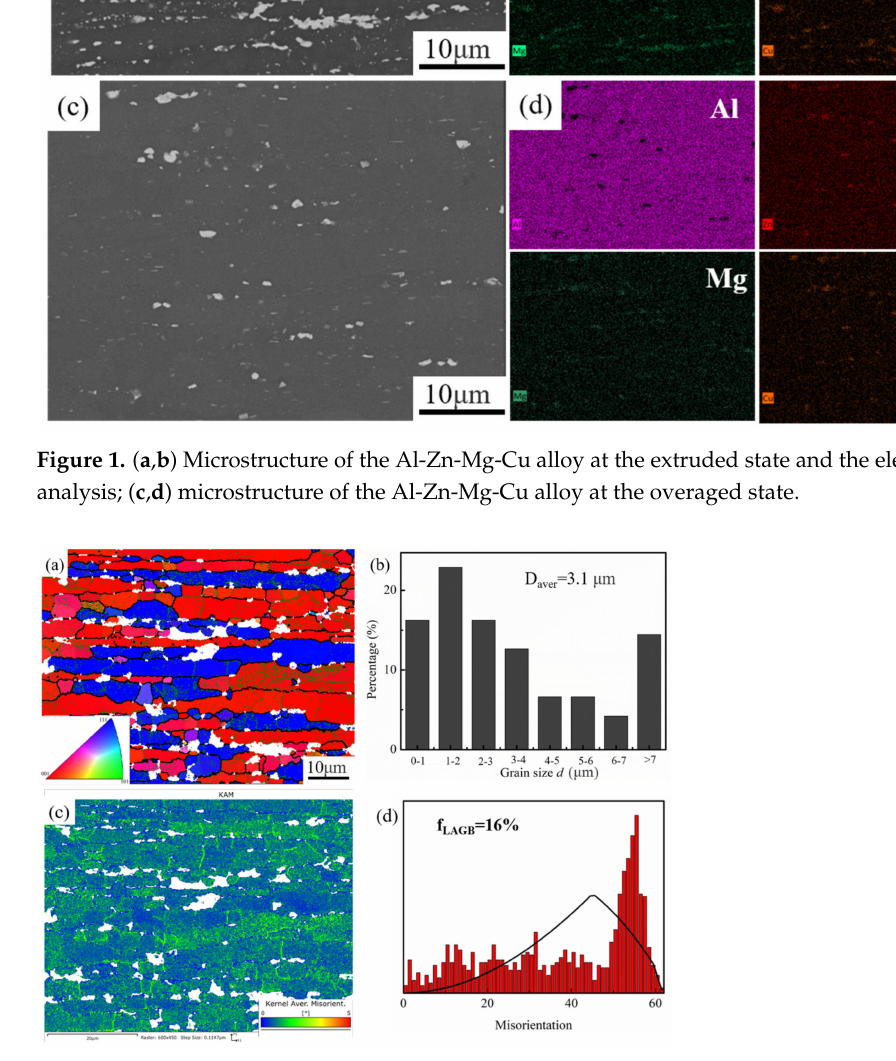
Figure 2. ( a ) Inverse pole figure (IPF) of the overaged Al-Zn-Mg-Cu alloy; ( b ) grain size distribution of the overaged Al-Zn-Mg-Cu alloy; ( c ) KAM image; ( d ) misorientation